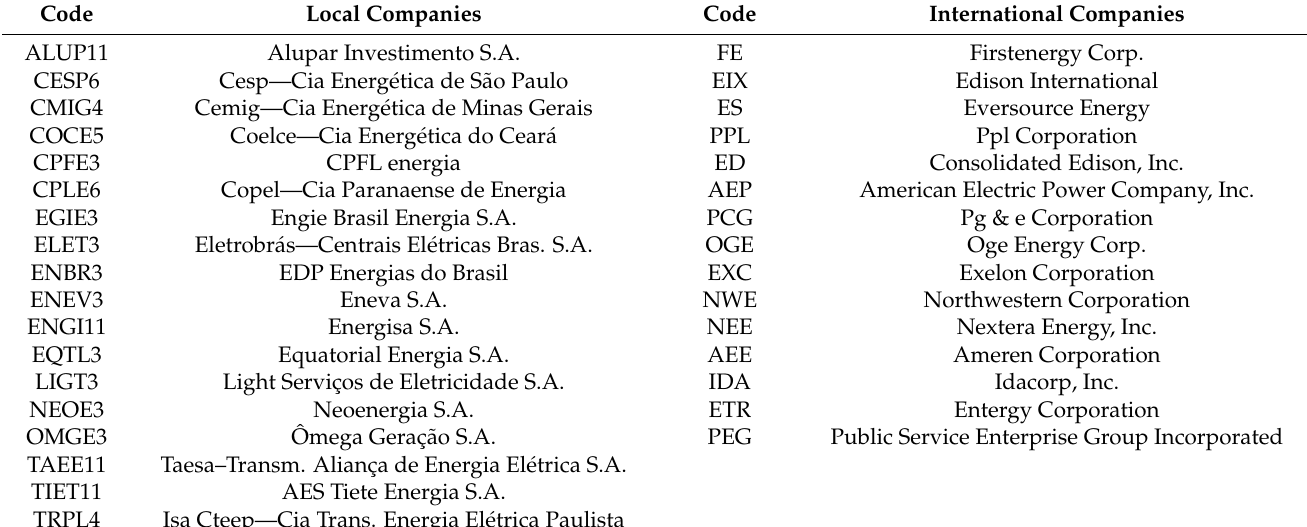
Table 1. Companies in the local and international market, which make up the Electric Energy Index (IEE) and Edison Electric Institute (EEI),